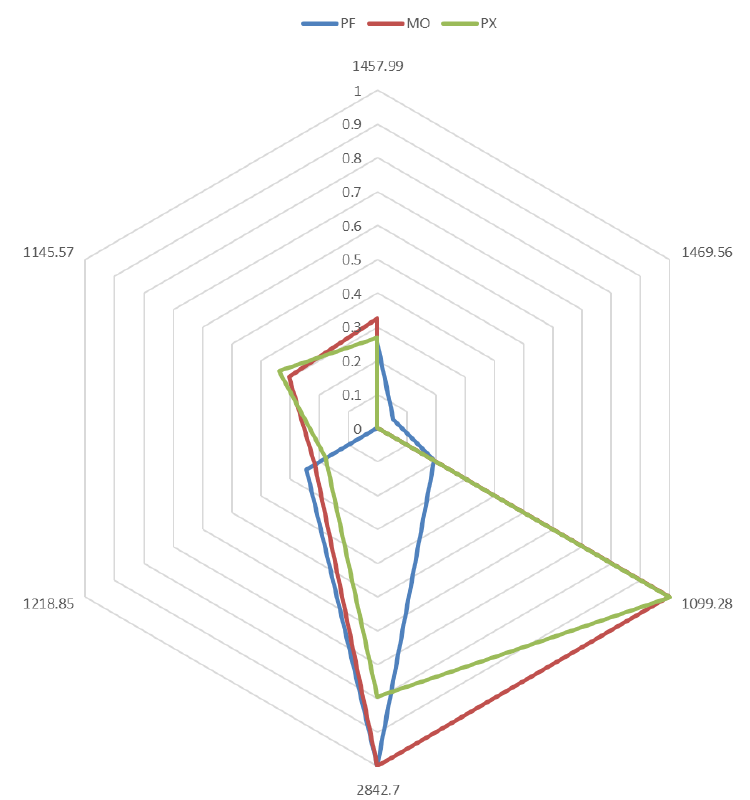
Figure 5. Characteristic spectralprint of each wine vinegar type.